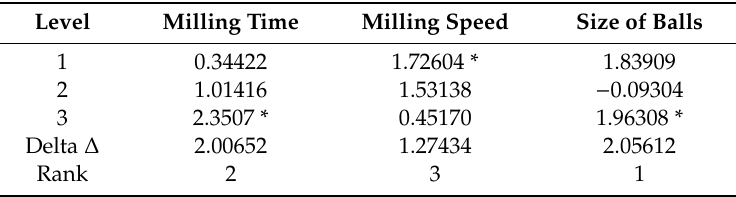
Table 4. Signal to noise ratio for each parameter and level.